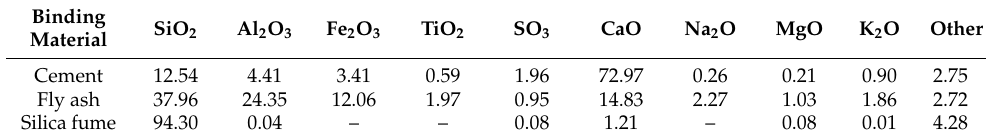
Table 1. Chemical composition of cement, fly ash, and silica fume (% by